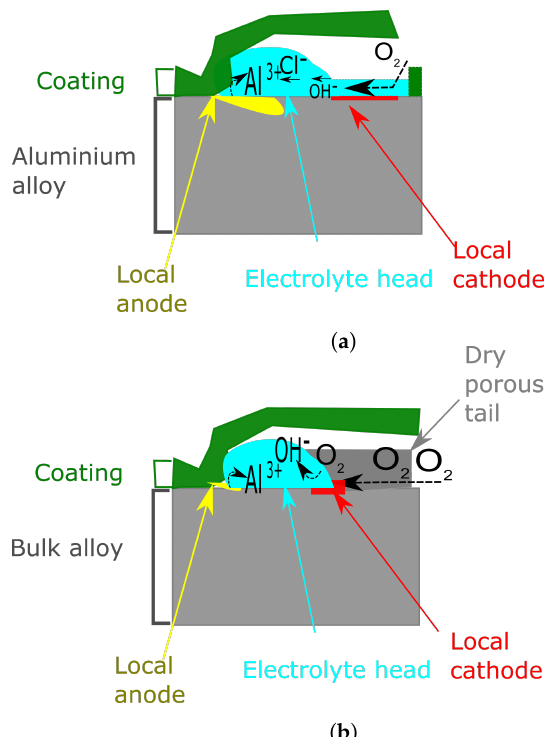
Figure 12. Schematic diagram showing the process of initiation ( a ) and propagation (b ) of FFC on aluminium. This schematic was based on the theory illustrated by Williams et al. Data from